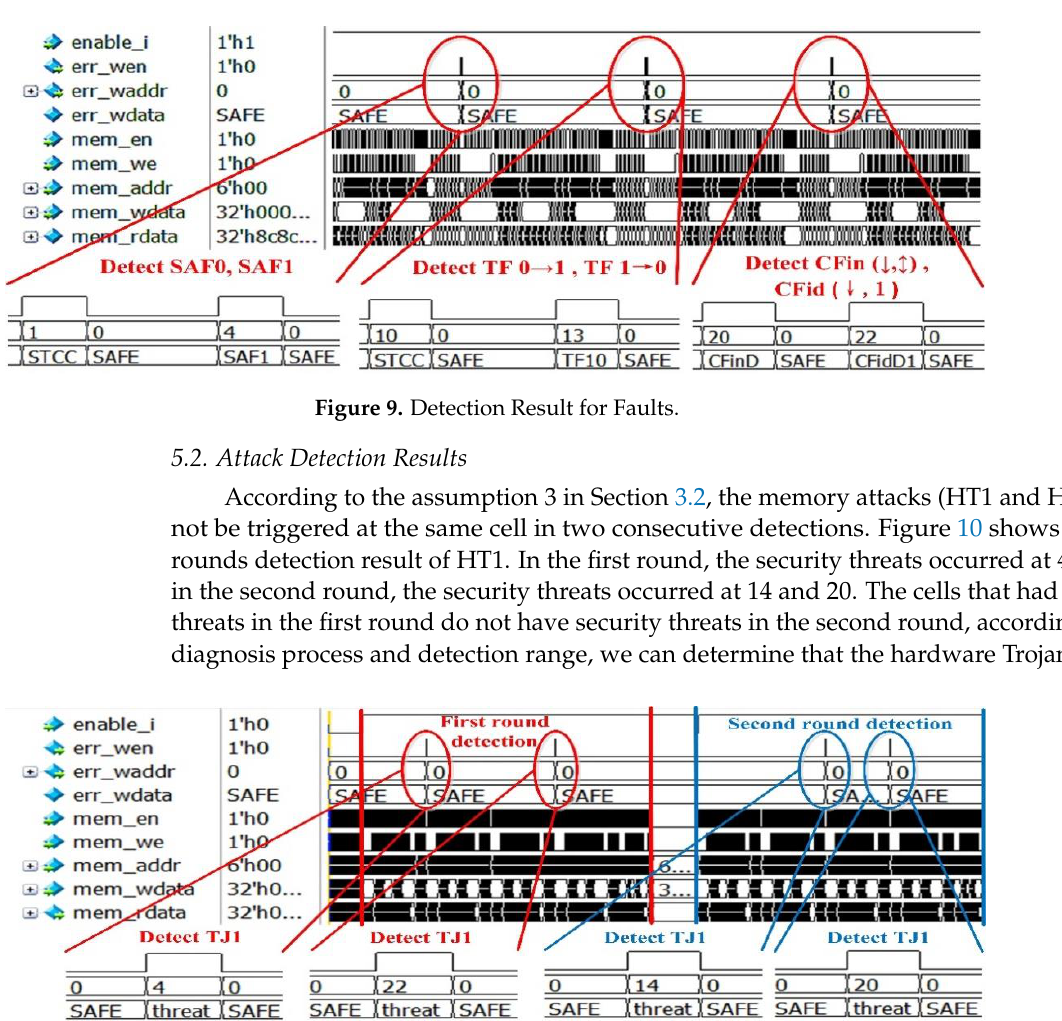
Figure 11. Detection result for HT2.